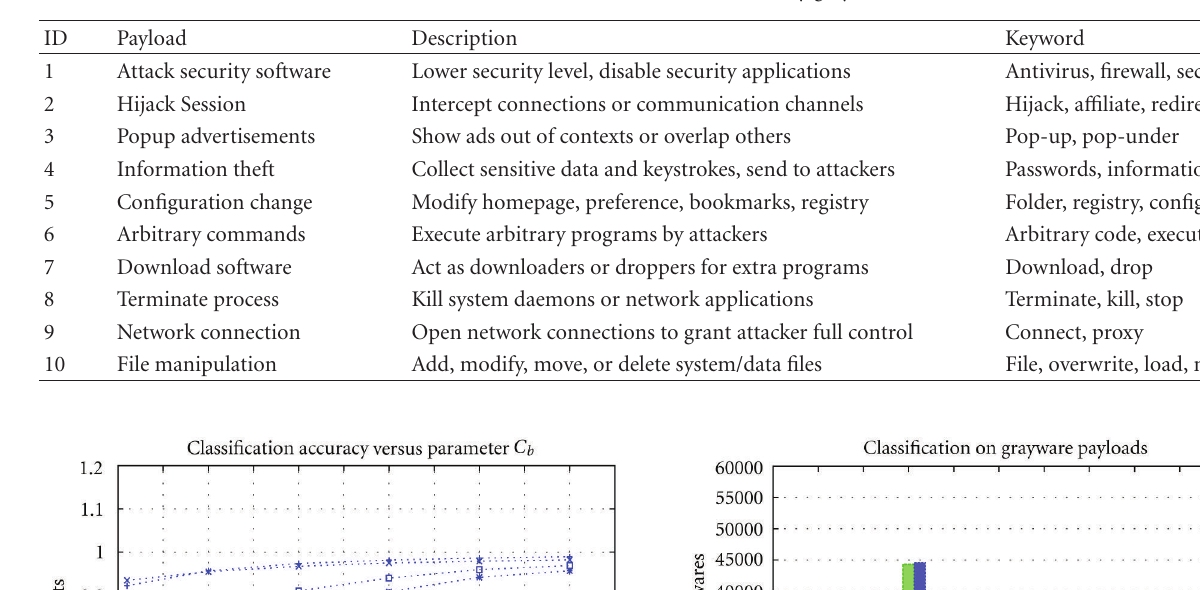
Table 5: Malicious activities carried out by grayware.